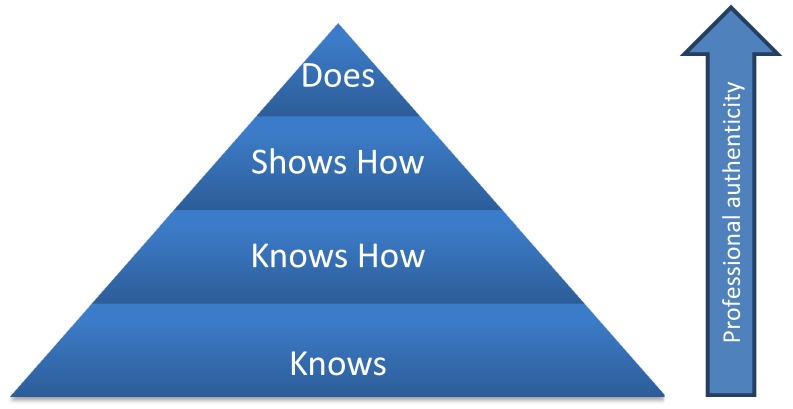
Miller pyramid [11]